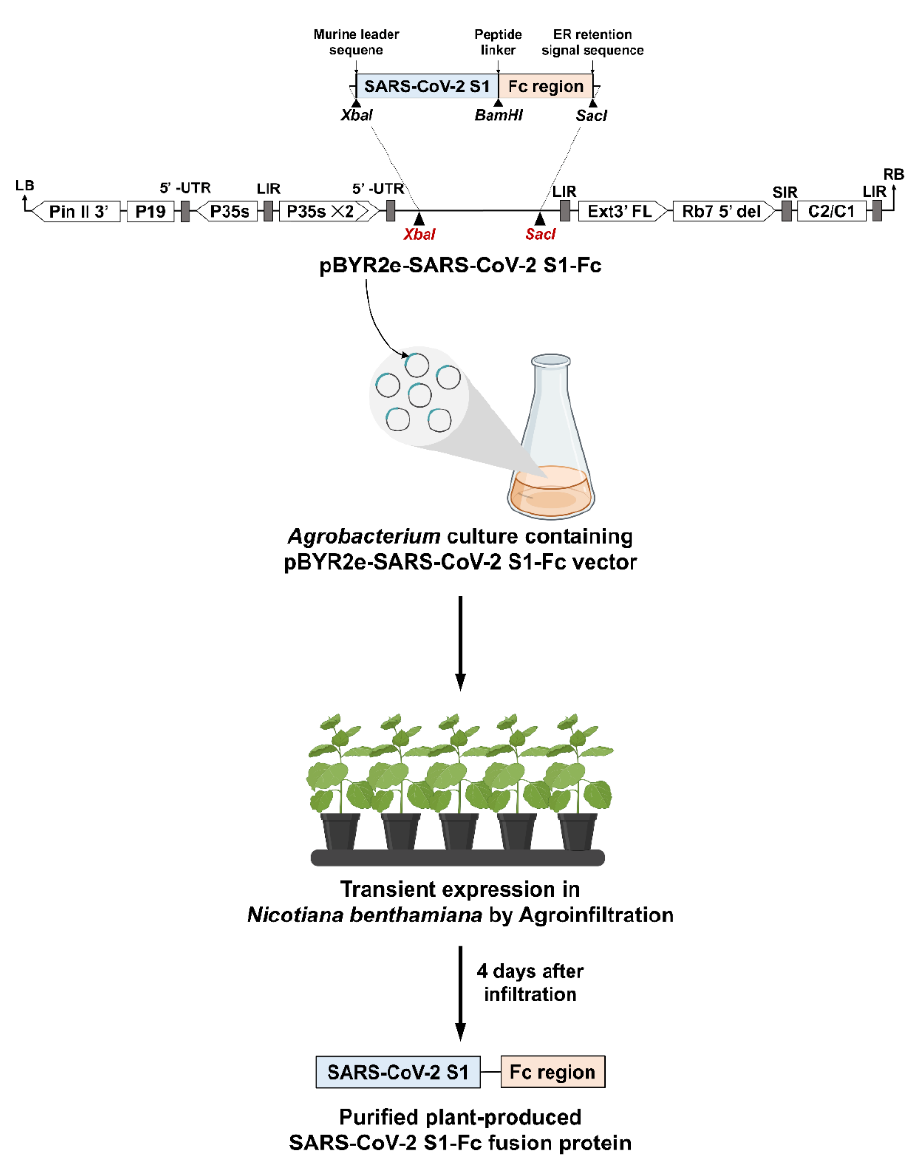
Figure 1. Schematic illustration shows the T-DNA of pBYR2e-SARS-CoV-2 S1-Fc plant expression vector and the N. benthamiana plants’ transient expression in brief. The left and right margins of the T-DNA employed in the transfer of Agrobacterium DNA into plant cells, RB and LB; as a terminator, the potato proteinase inhibitor II gene was used, Pin II 3 ′ ; the Tomato Bushy Stunt Virus (TBSV) as an RNA silencing suppressor, P19; the Cauliflower Mosaic Virus (CaMV) serves as a 35s promoter, P35s; the CaMV with duplicated enhancer as a 35s promoter, P35s × 2; the region of tobacco extension gene, Ext3 ′ FL, 3 ′ ; the tobacco RB7 promoter, Rb7 5 ′ del; the Bean Yellow Dwarf Virus (BeYDV) short intergenic region, SIR; the BeYDV long intergenic region, LIR; the BeYDV encoding for replication initiation protein (Rep) and RepA as a Rep/RepA gene, C2/C1.